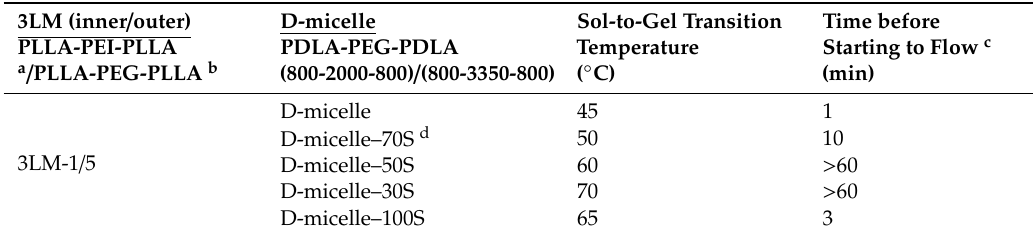
Table 2. Comparison of so-to-gel transition and stability of 10 wt % stereocomplexed hydrogels using D-micelles with mixed PEG length ( inner:outer of 3LM kept 1 /